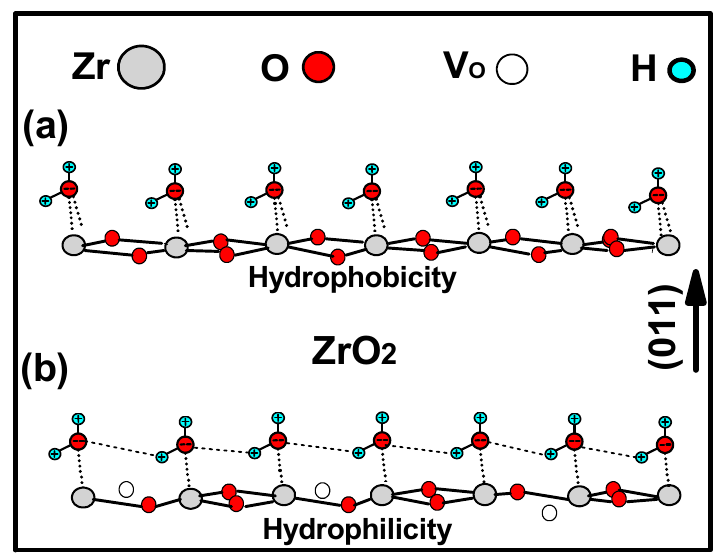
Figure 8. Schematic diagram of the tetragonal (111) surface of ZrO 2 for hydrophobic ( a ) and hydrophilic ( b ) properties of the material. Dot lines represent the two dipoles obtained from the two H + with O 2+ in the H 2 O molecule.